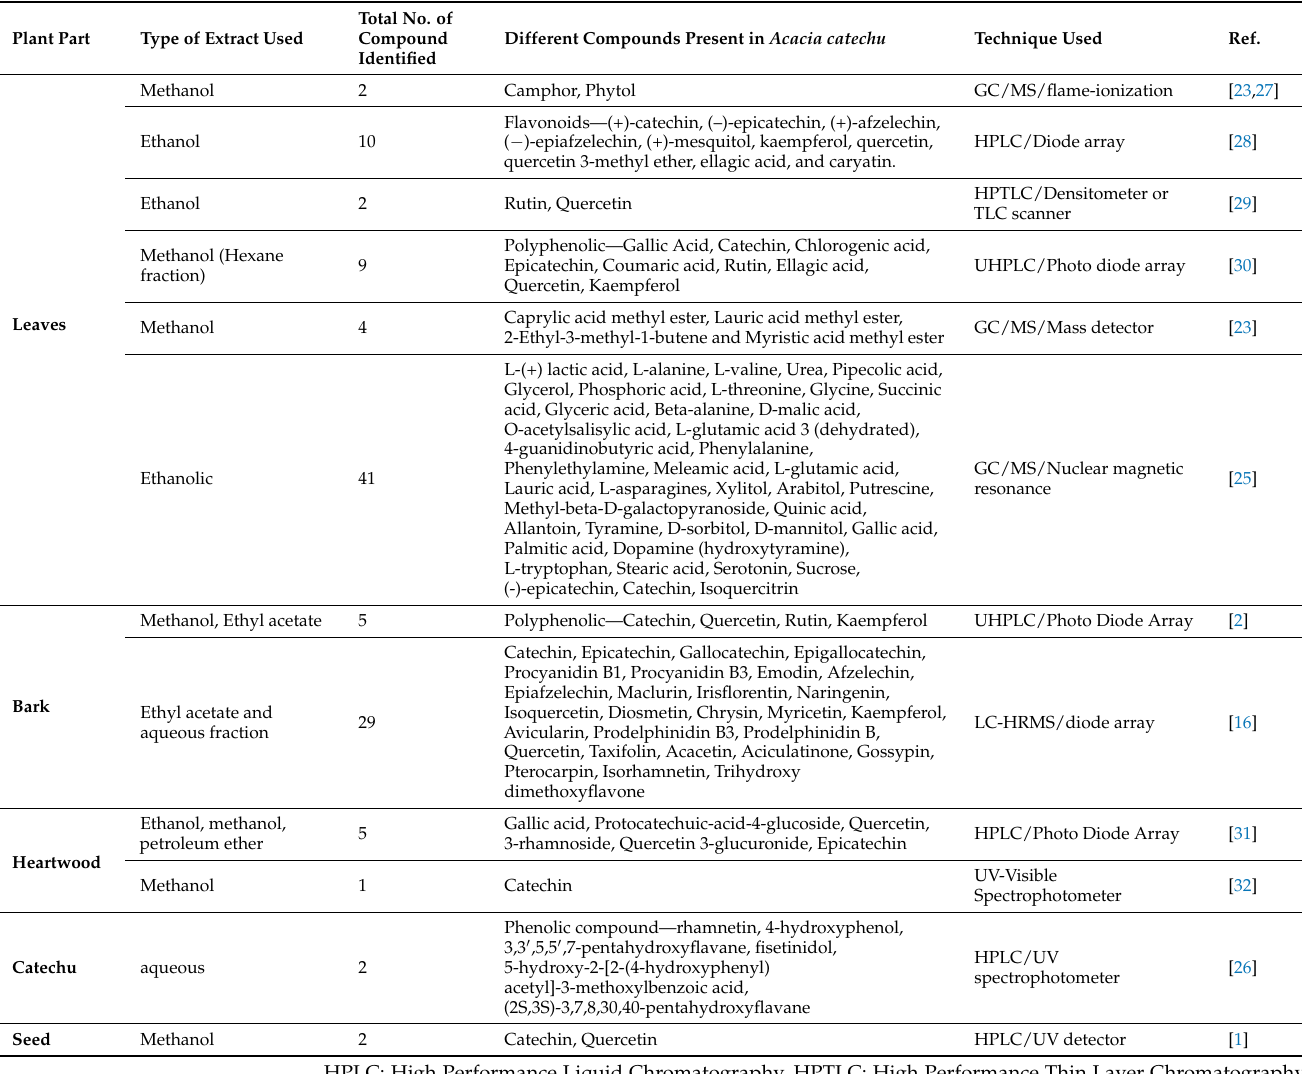
Table 1. Different Compounds are present in different parts of Acacia catechu in different